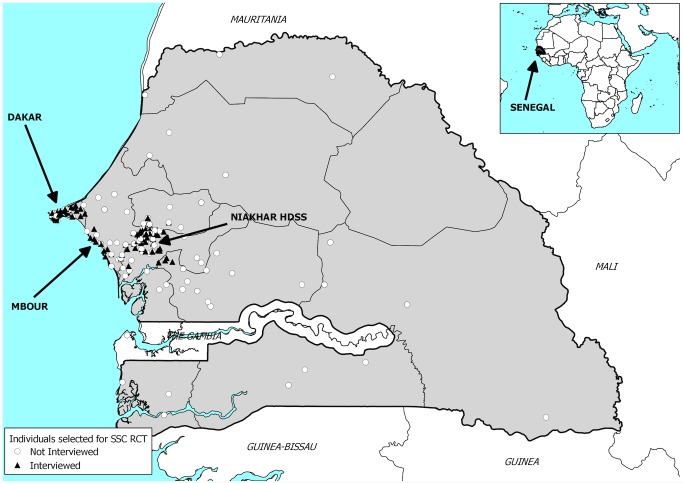
Map of the study site.Location of study participants in Senegal. Black triangles represent interviewed respondents, and white circles represent sampled individuals who did not participate in the validation study, either because they refused, were absent, or could not be traced. RCT, randomized controlled trial.